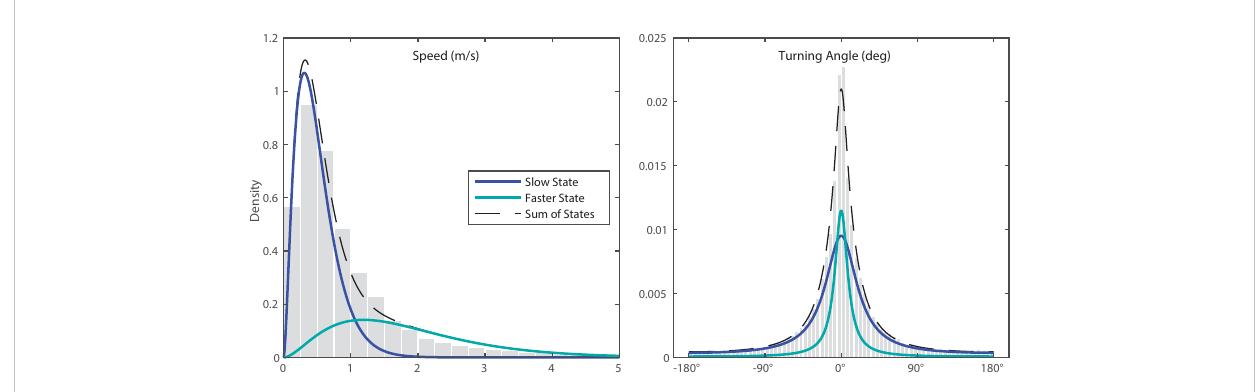
FIGURE 5 Distributions of the observed variables measured in 5 min intervals for the minke whale CRAWL tracks normalized by the probability density function. The gray histograms show the observed values normalized by the area of each bar, the blue curves show the probability density function of the Slow State, the teal curves show the probability density function of Faster State, and the black dashed lines show the sum of two states. The kinematic states were estimated using a hidden Markov